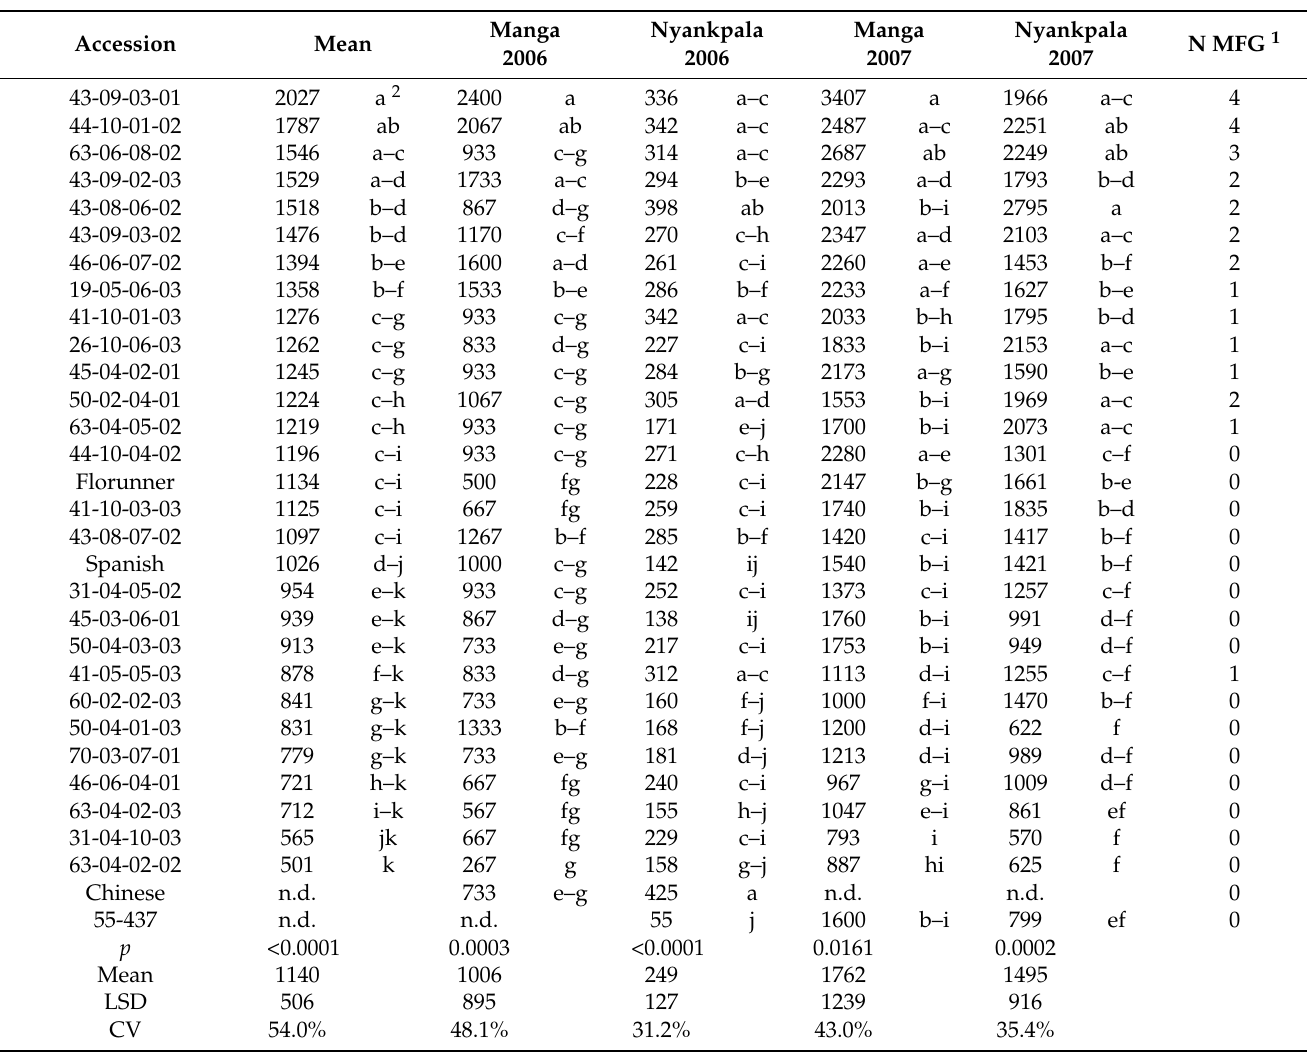
Table 5. Pod yield (kg ha − 1